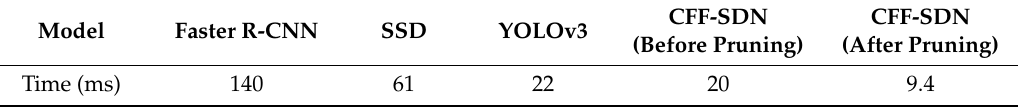
Table 5. Average time cost of ship detection by di ff erent models.